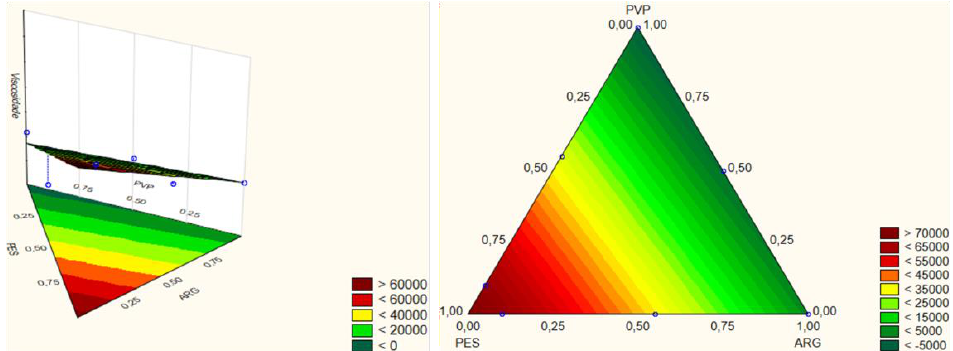
Figure 5. Response surface graph and contour graph according to the linear model for viscosity.